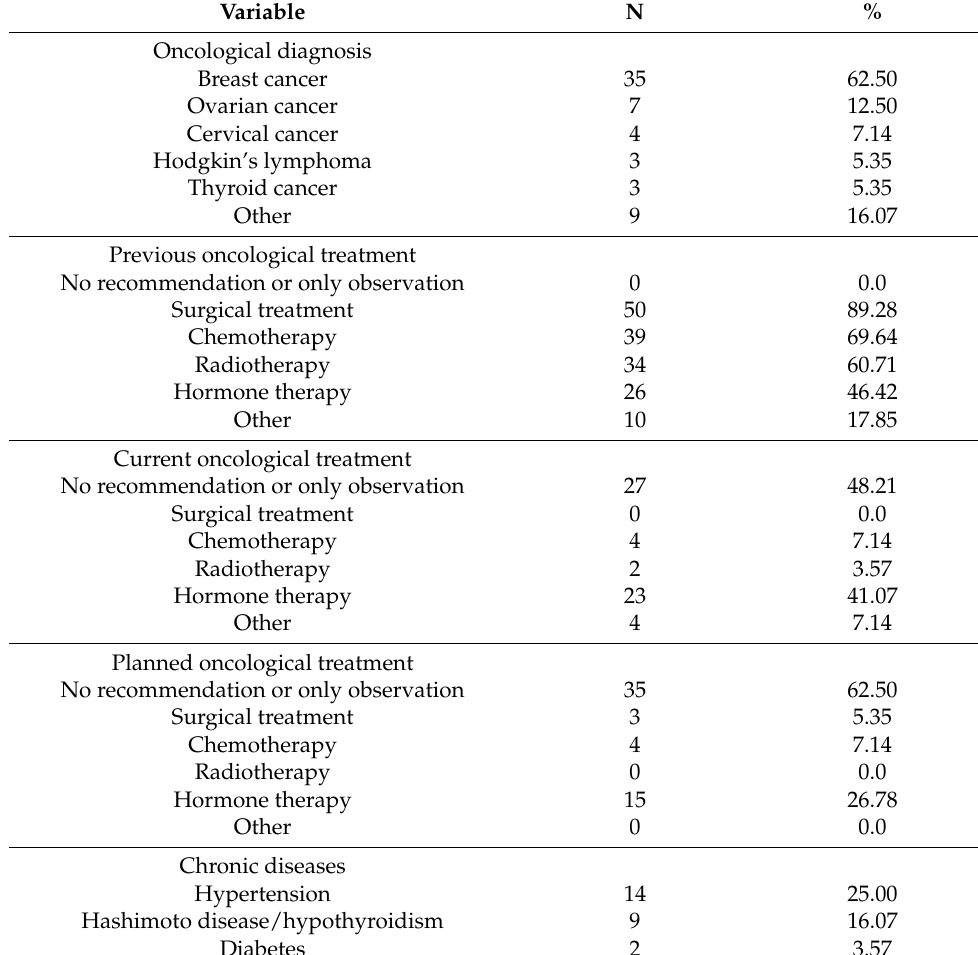
Table 2. Clinical